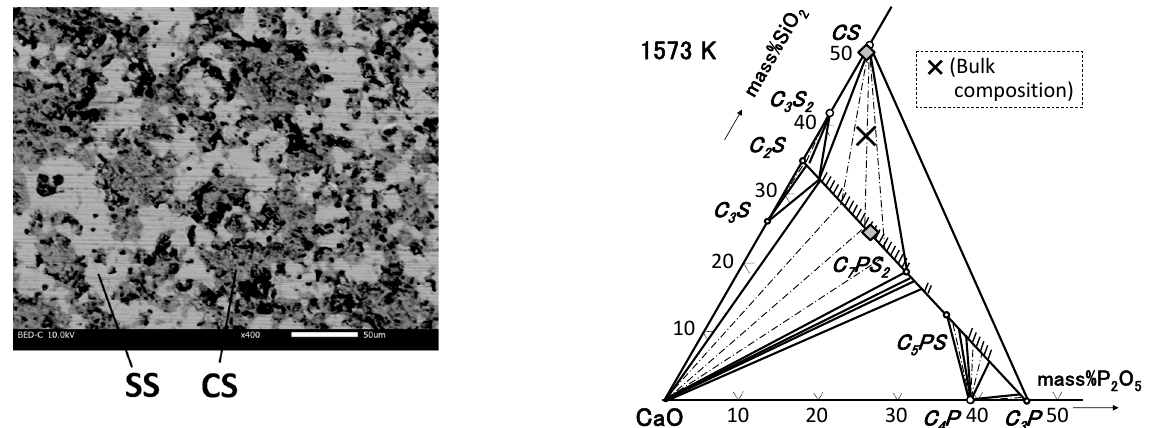
Figure 2. Schematic illustration of the experimental setup.